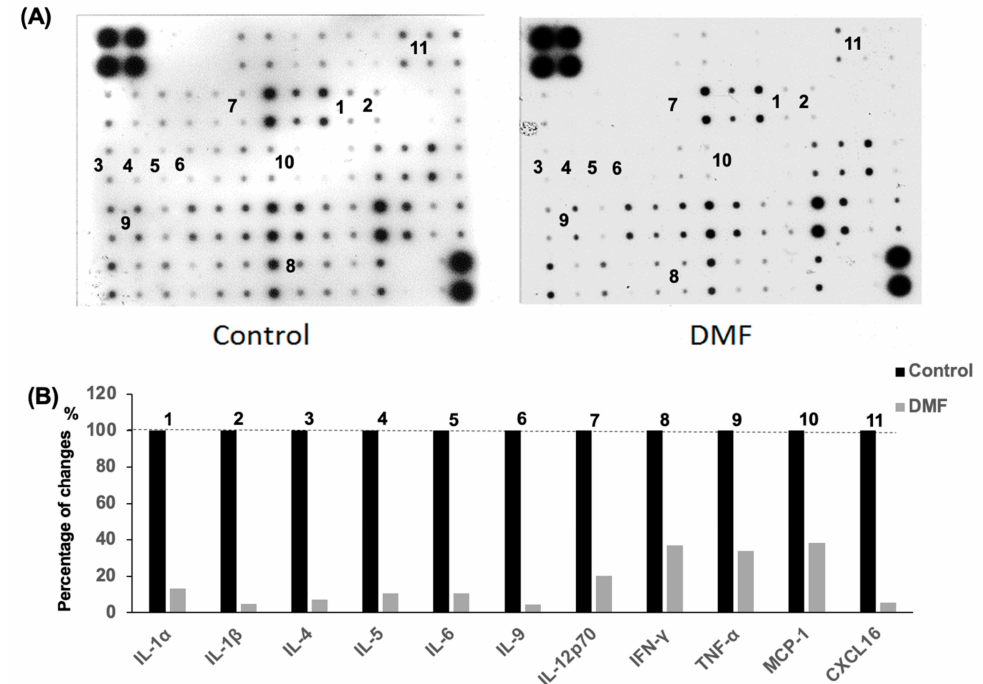
Figure 5. Impact of DMF treatment on serum cytokine levels in accelerated NOD mouse model. ( A ) The systemic inflammatory state was assessed using the mouse cytokine and chemokine array assay. Sera from five mice in each group were used for the assay. There were duplicated spots for each cytokine or chemokine. ( B ) Relative expression in the DMF group was calculated using control group as the benchmark. The levels of cytokines and chemokines including IL-1 α , IL-1 β , IL-2, IL-4, IL-5, IL-6, IL-9, IL-12p70, IFN- γ , TNF- α , MCP-1 and CXCL16 were lower in DMF-treated compared to control group ( n = 5 for each